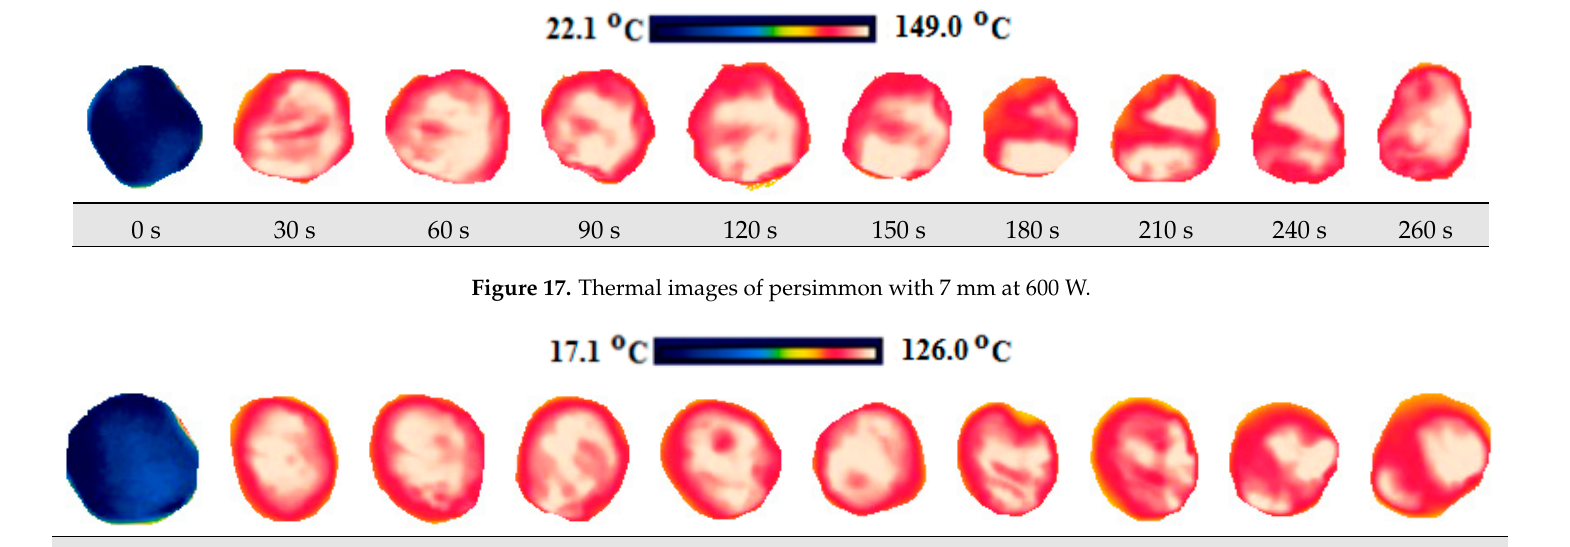
Figure 16. Thermal images of persimmon with 7 mm at 460 W.